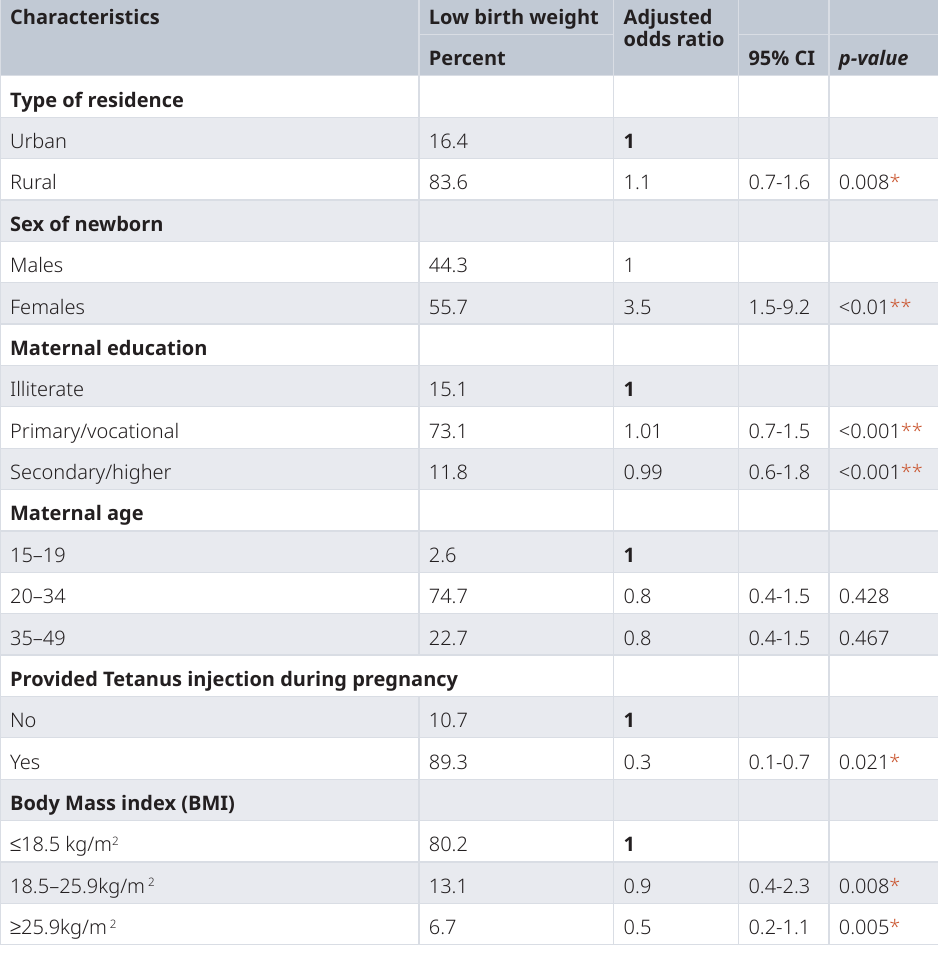
Table 3. Multivariate logistic regression for the risk factors associated with low birth weight.